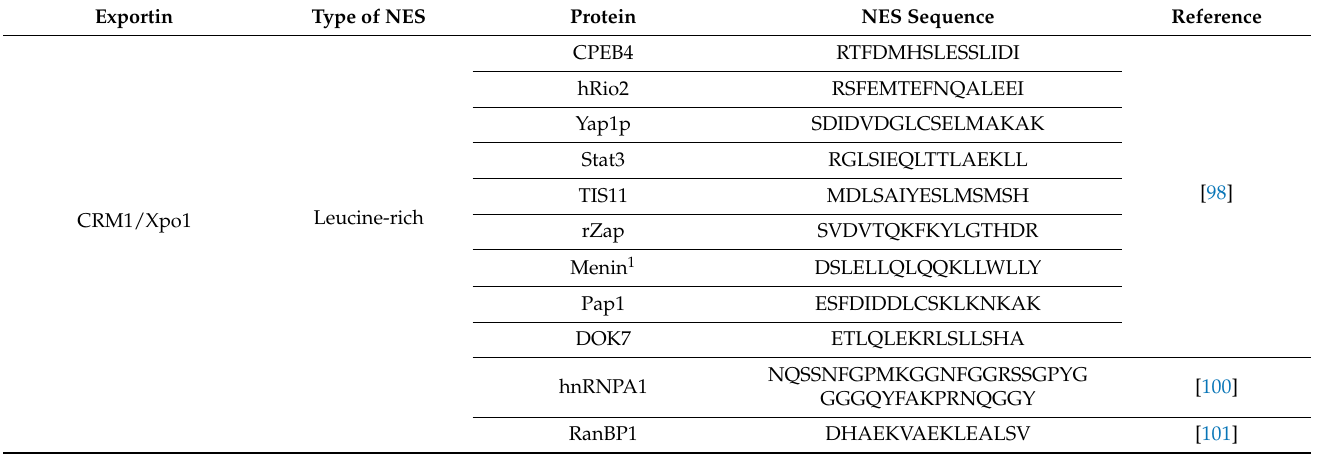
Table 3. Exportins-NES